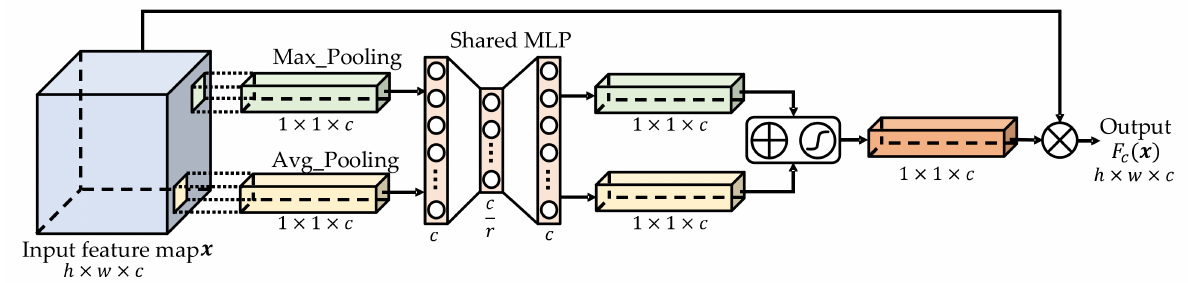
Figure 7. Structure of the channel attention